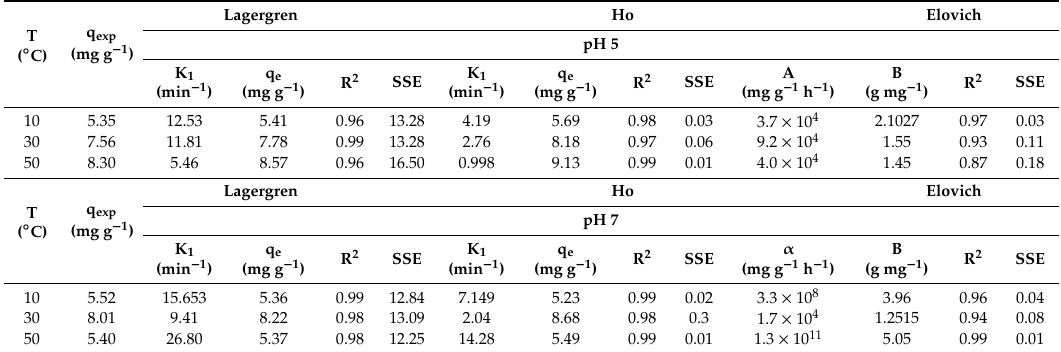
Table 1. Summary of adjustment of experimental data to kinetic models.